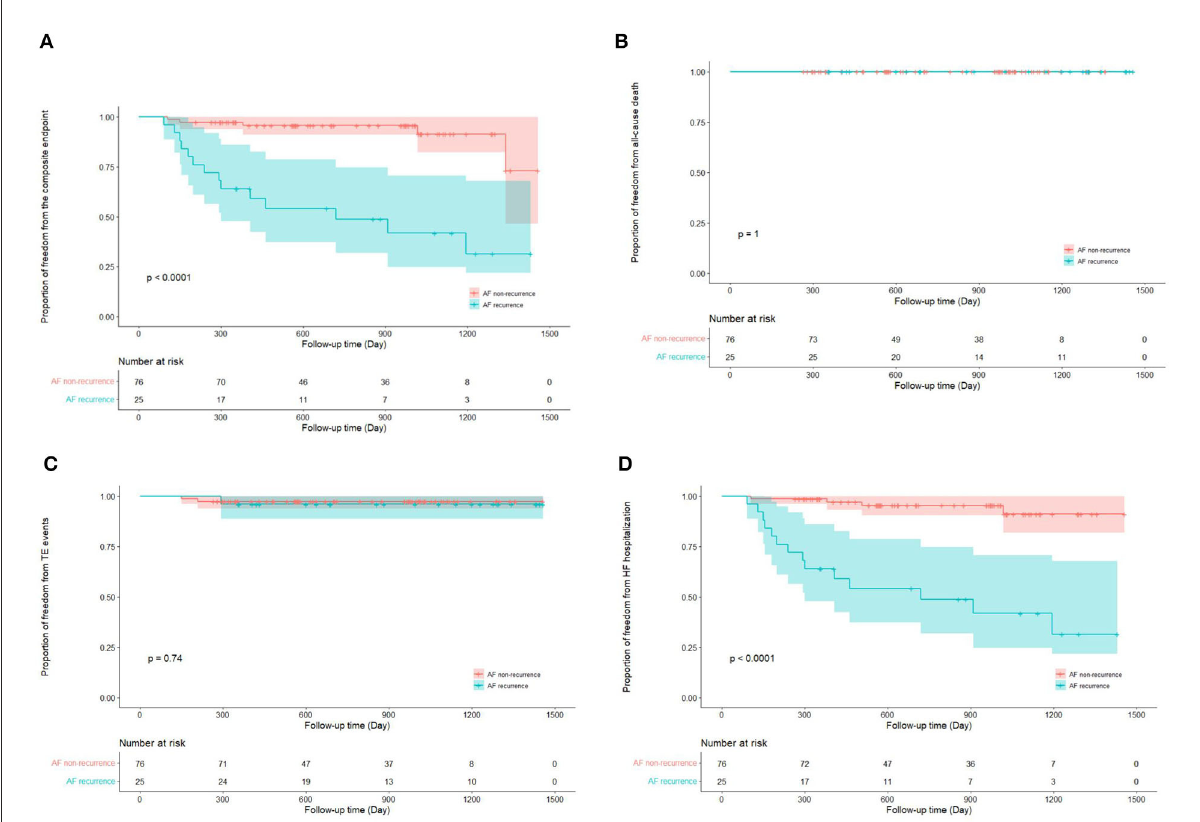
FIGURE4 Kaplan–Meier curves show the incidence of the composite endpoint (A) . All-cause death (B) , thromboembolic events (C) , heart failure hospitalization (D ) in patients with and without atrial fibrillation recurrence after multiple procedures. AF, atrial fibrillation; TE, thromboembolism; HF, heart failure.